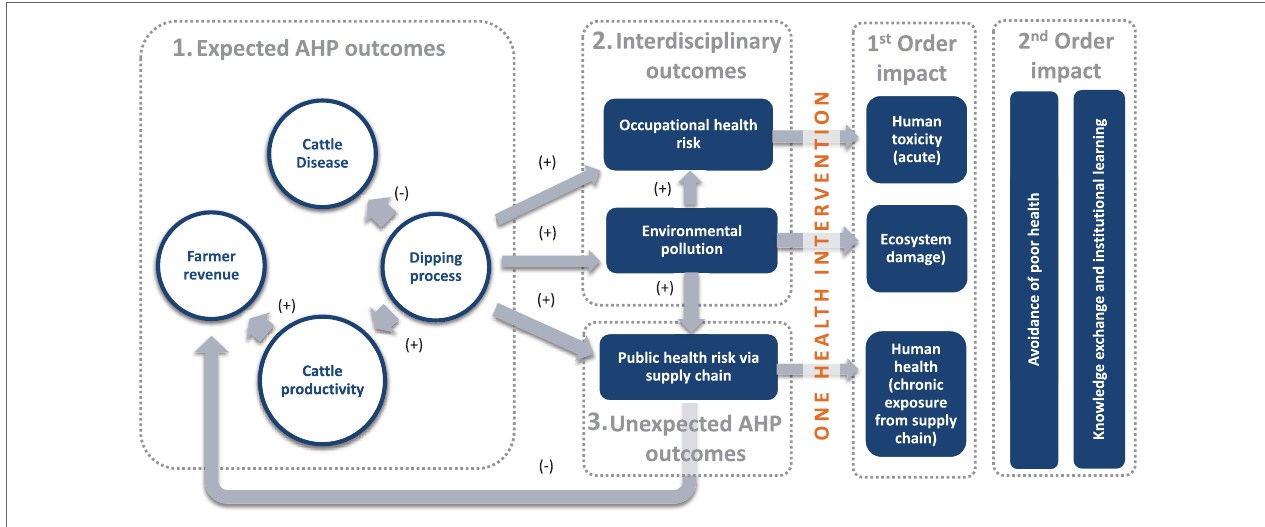
Figure 2 | Logical framework showing Impact Pathways describing interactions between inputs, outputs, outcomes, and impact of the system of the Animal Health Programme (AHP) and OHI. The system relating to the primary AHP (Box 1) showing the “theory of change,” i.e., interdisciplinary outcomes arising from the AHP (Box 2) and highlighting the impact pathways on which the One Health Initiative acts with both first order and second order impacts assumed. The figure also shows where unexpected outcomes (Box 3) were captured through the adoption of the transdisciplinary approach used in this